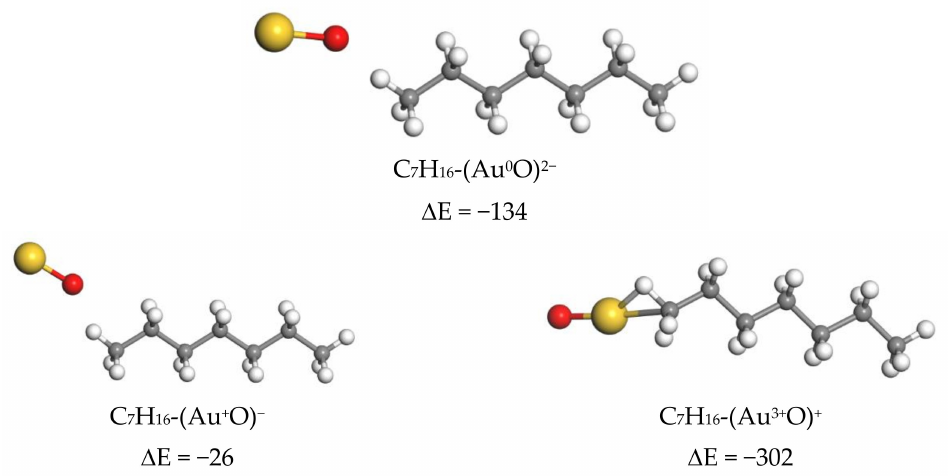
Figure 8. Optimized structures of C 7 H 16 -(Au 0 O) 2 − , C 7 H 16 -(Au + O) − and C 7 H 16 -(Au + 3 O) + . Calculated adsorption energies are given in kJ /